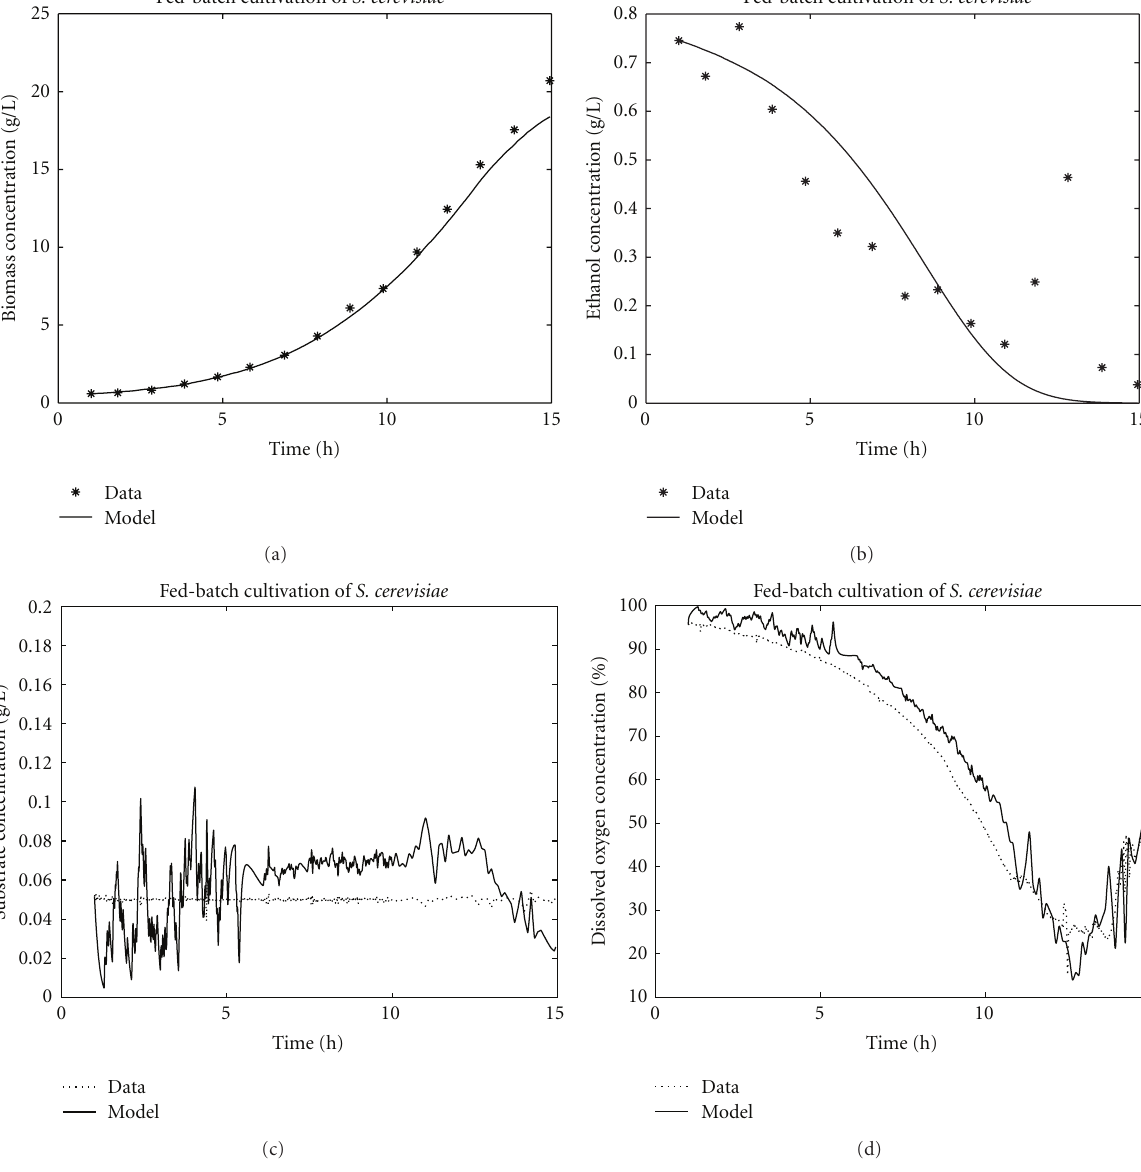
Figure 2: Model prediction compared to experimental data, respectively, for biomass, ethanol, substrate, and dissolved oxygen concentra-